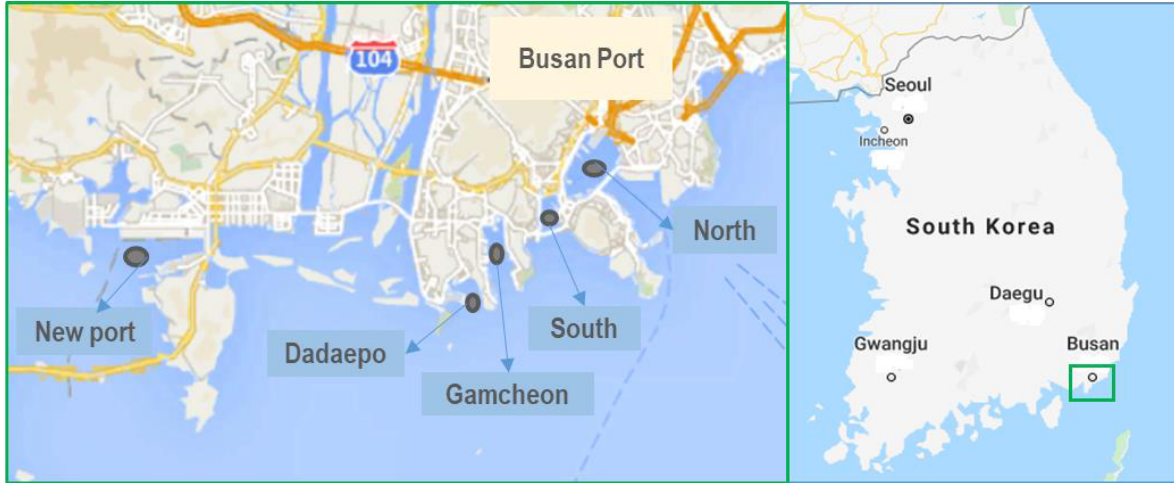
Figure 1. Geographical location of Busan Port, consisting of five harbours (New, Dadaepo, Gamcheon, South, and North) along the Korean Peninsula.